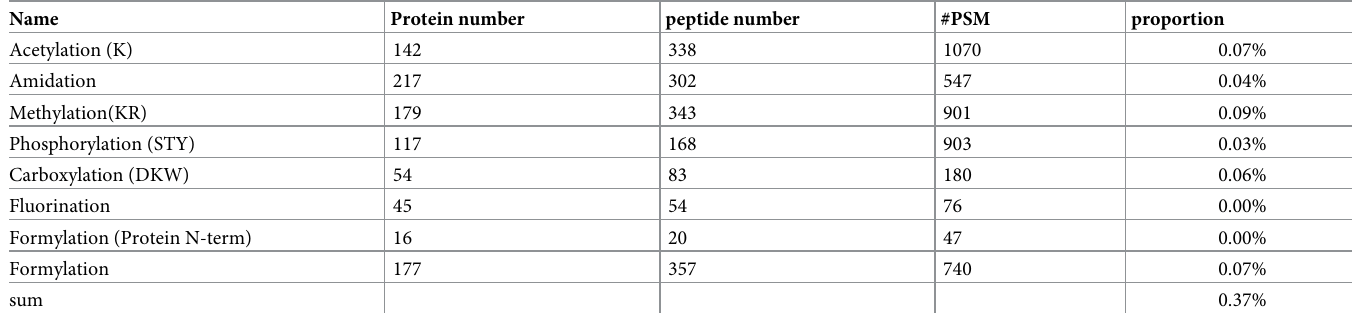
Table 3. The post-translational modifications of BAT